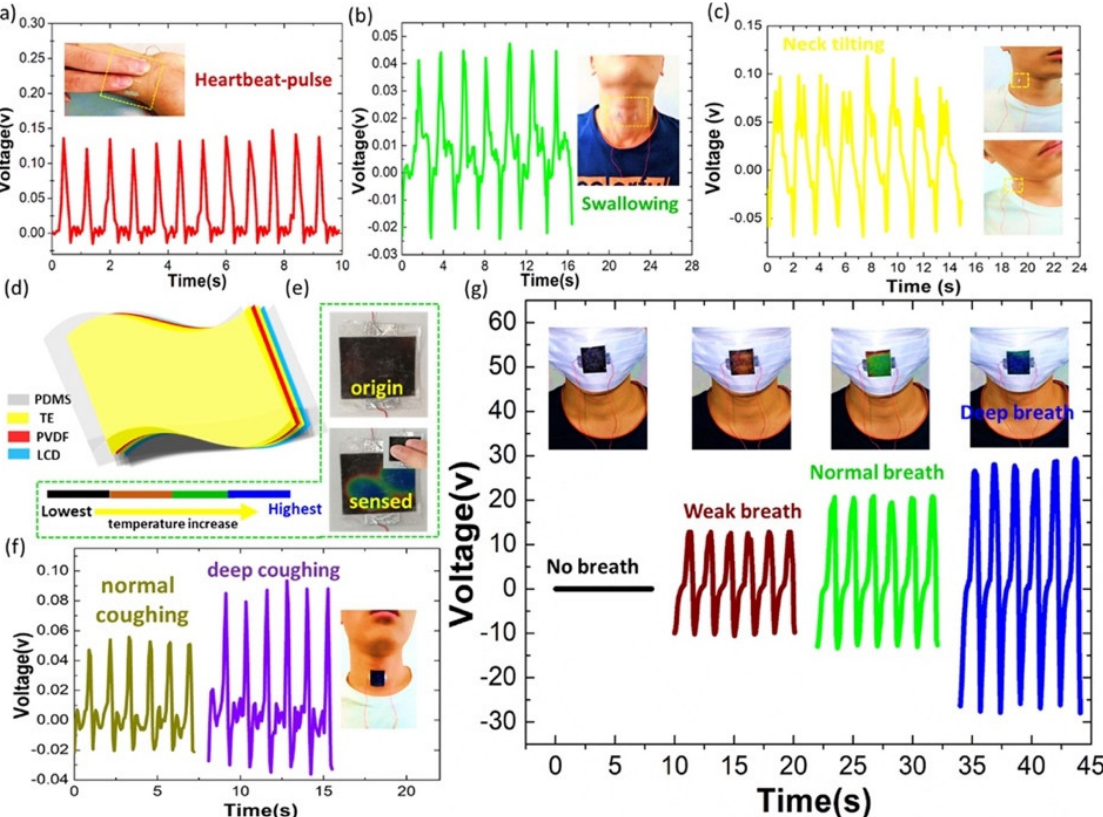
Figure 7. Potential applications of the flexible hybrid nanogenerator reported by Sun et al. [104]. Voltage output of the hybrid nanogenerator for assessing ( a ) heartbeat pulse, ( b ) swallowing, and ( c ) neck tilting. ( d ) Schematic view of a smart device composed of transparent hybrid nanogenerator and LCD film. ( e ) Smart device for temperature monitoring. ( f ) Voltage output of the smart device for sensing different degrees of coughing. ( g ) Voltage output of the smart device for monitoring three types of breathing conditions. Reprinted with permission from [104]. Copyright 2018, Else- vier Ltd.